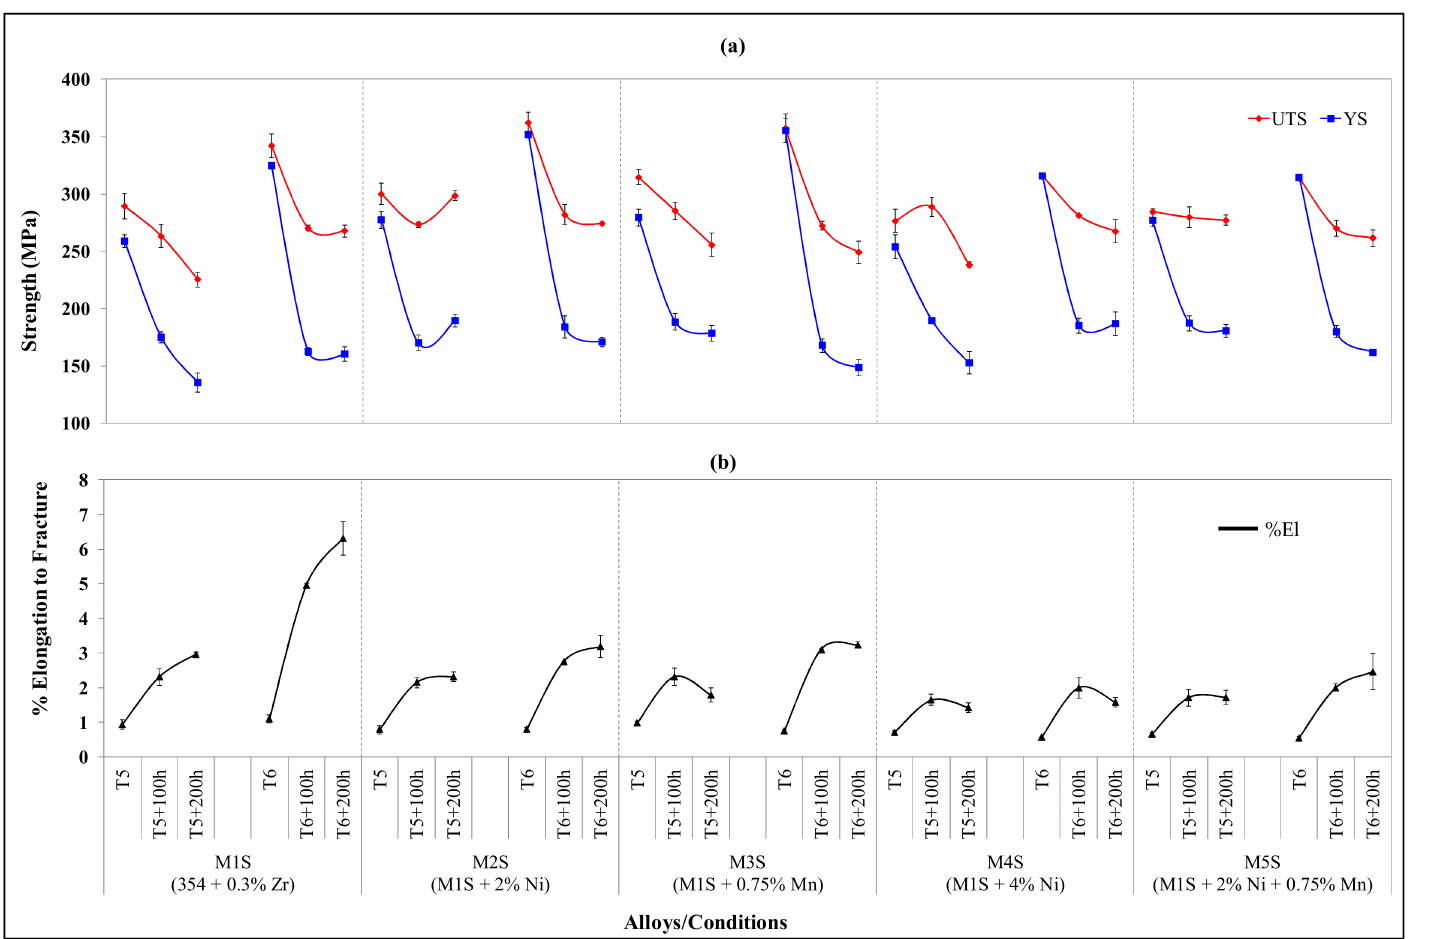
Figure 2. Variation in average UTS, YS, and %El values for alloys M1S through M5S in the T5, T6, and after static stabilization at 250 ◦ C for 100 h, and 200 h (testing at ambient temperature: ( a ) UTS and YS; ( b )